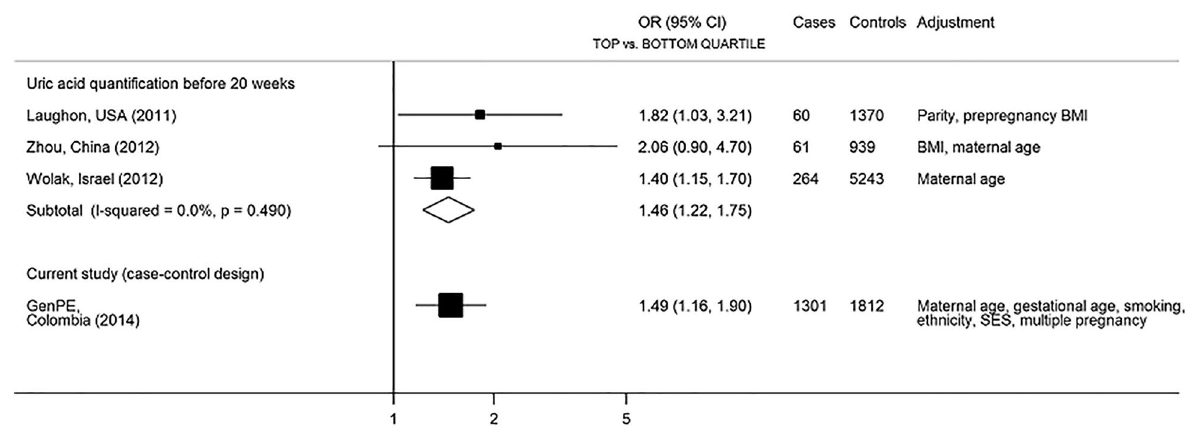
Figure 3. Summary estimates for a comparison between top and bottom quartiles of uric acid for prospective studies with uric acid measured in early pregnancy compared to GenPE results. The p value corresponds to heterogeneity hypothesis testing among studies included in the